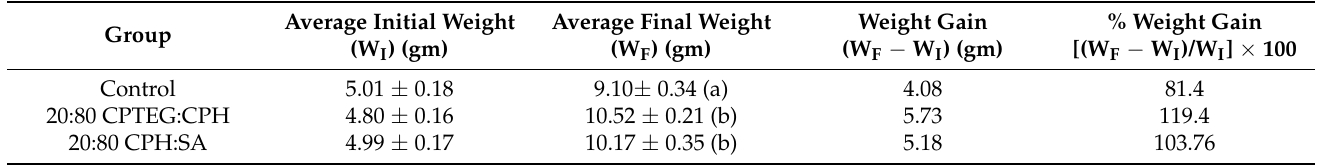
Table 2. Shrimp weight gain post-nanoparticle administration.